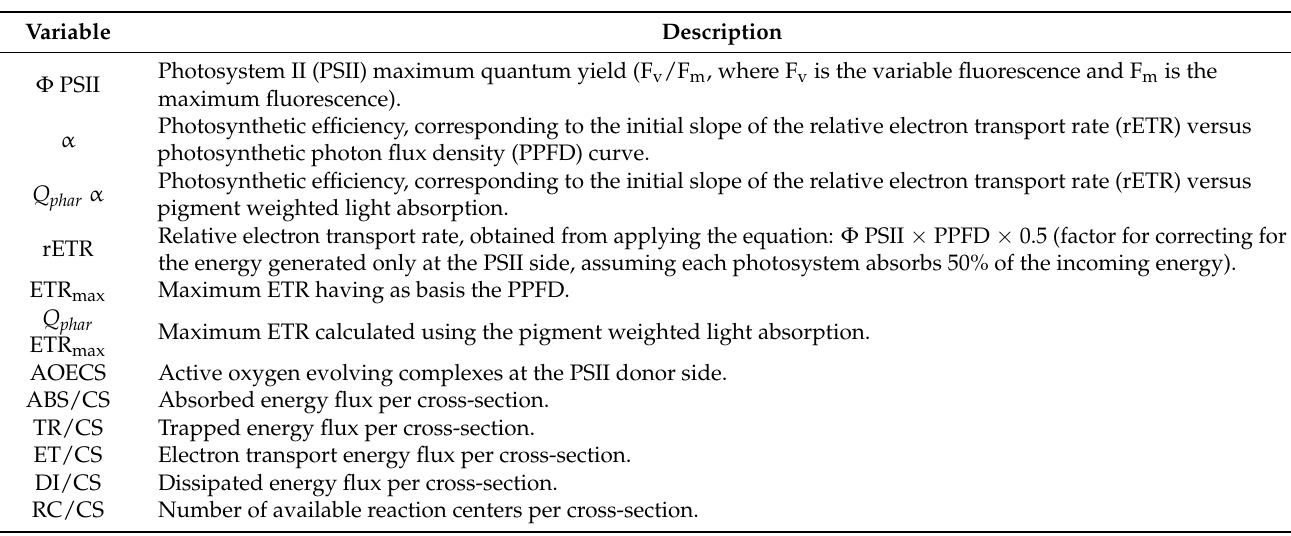
Table 1. Summary of fluorometric analysis parameters and their